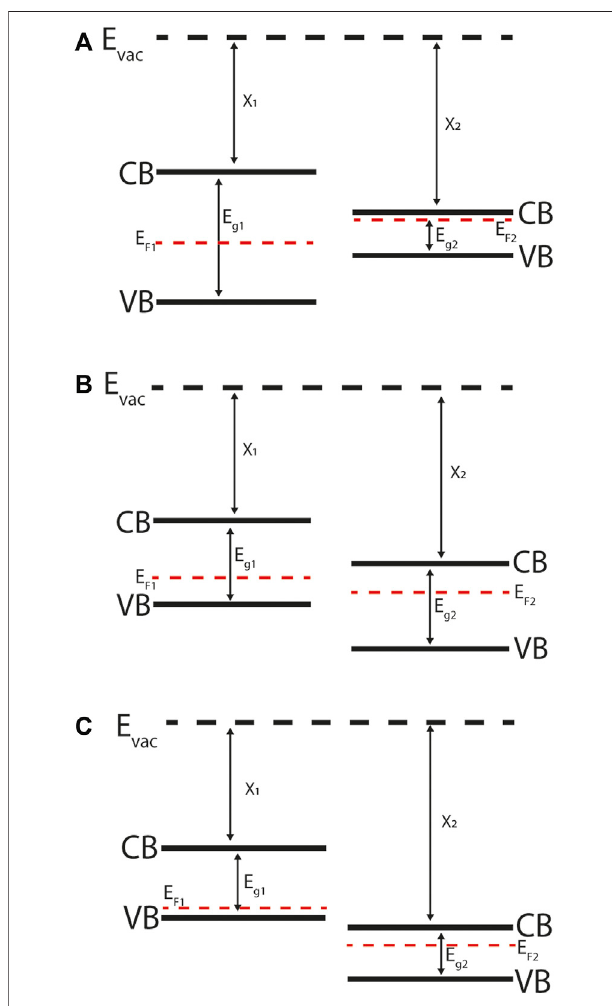
FIGURE 2 | Energy band diagrams of abrupt semiconductor- semiconductor heterojunctions: (A) Straddling gap (Type-I), (B) Staggered gap (Type-II), (C) Broken gap (Type-III). Note that the materials are not in contact or in equilibrium with one-another, asindicated bythe mismatch between their Fermi levels ( E F ). CB is the conduction band (minimum) and VB is the valence band (maximum) referenced to the vacuum level E vac . For quantitative predictions of band alignment the electron af fi nity ( χ ) and band gap( E g )areusedintheAndersonrule,whichassumesthatthevacuumlevelis